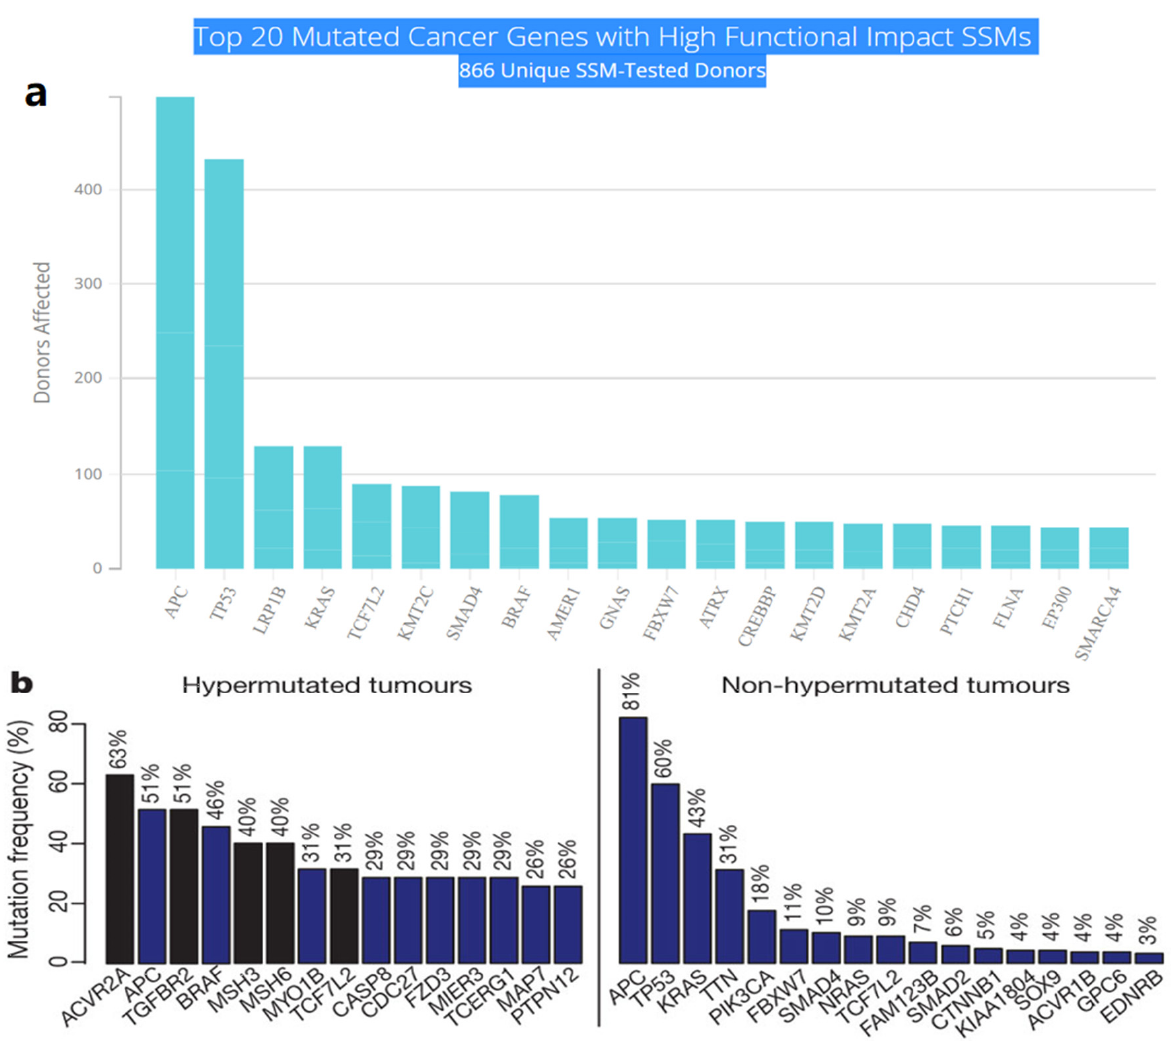
Figure 1. ( a ) The top 20 mutated genes with high functional impact involved in colorectal cancer extracted from the ICGC Data Portal in three projects: Colon Adenocarcinoma—TCGA, US, Adenocar- cinoma, non-Western (China), Rectum Adenocarcinoma—TCGA, US. https://dcc.icgc.org/ (accessed on 15 December 2021) ( b ) Significantly mutated genes in hypermutated and non-hypermutated tumors adopted from The Cancer Genome Atlas Network